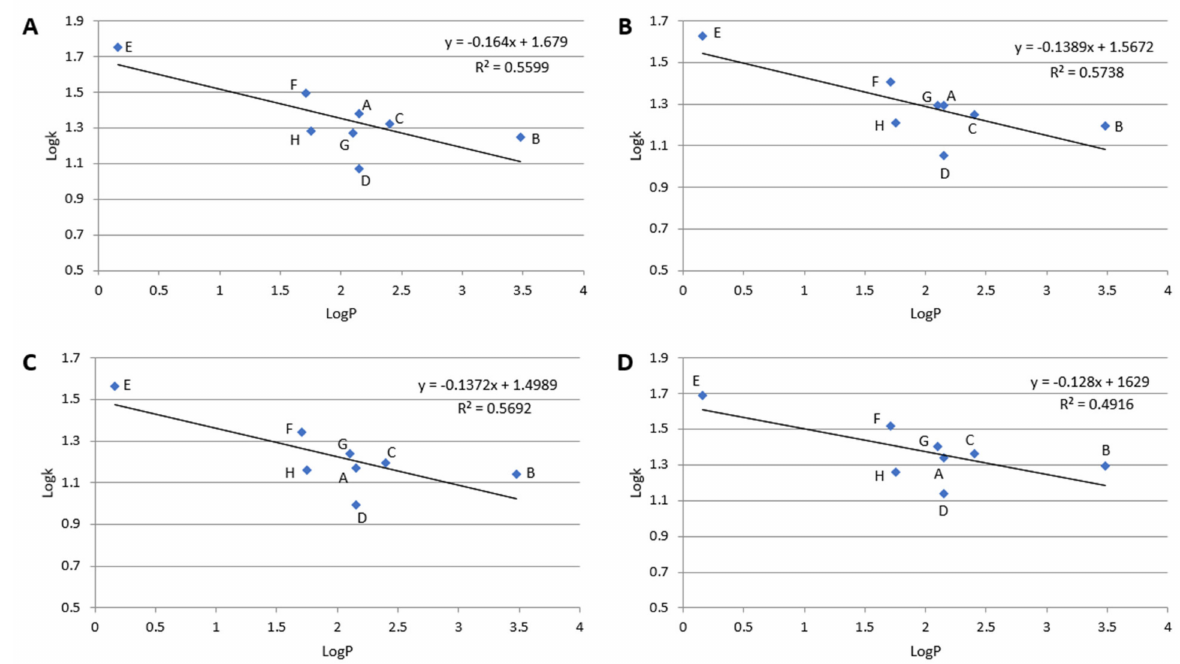
Figure 5. Dependences of log k vs. log P; ( A )–Diol–P–Benzyl, ( B )–Diol–P–C18, ( C )–Diol–P–C10, and ( D )–Diol–P–Chol measured for 90% ACN in 10 mM ammonium acetate in water. (A)–metoprolol, (B)–propranolol, (C)–ciciloprolol, (D)–mexiletine, (E)–atenolol, (F)–acebutolol, (G)–oxprenolol, and